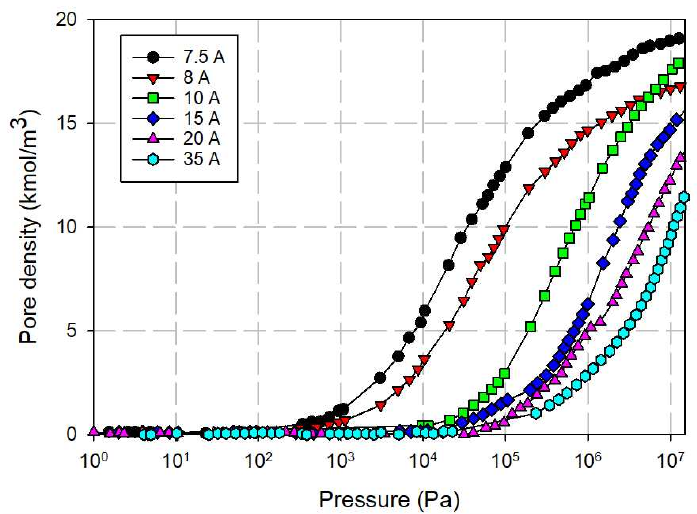
Figure 11. Adsorption isotherms of methane obtained for a finite-length slit pore at 273 K.